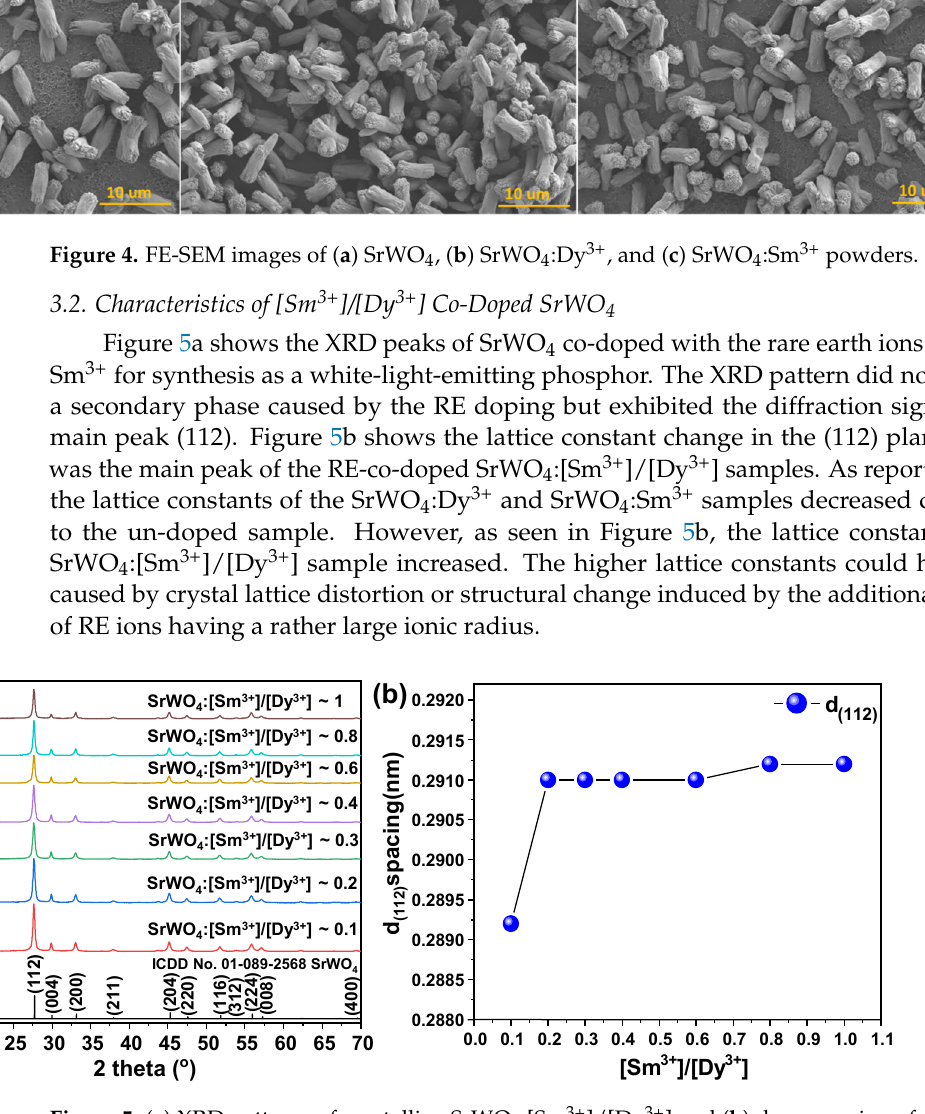
Figure 5. ( a ) XRD patterns of crystalline SrWO 4 :[Sm 3+ ]/[Dy 3+ ] and ( b ) d (112) spacing of samples.